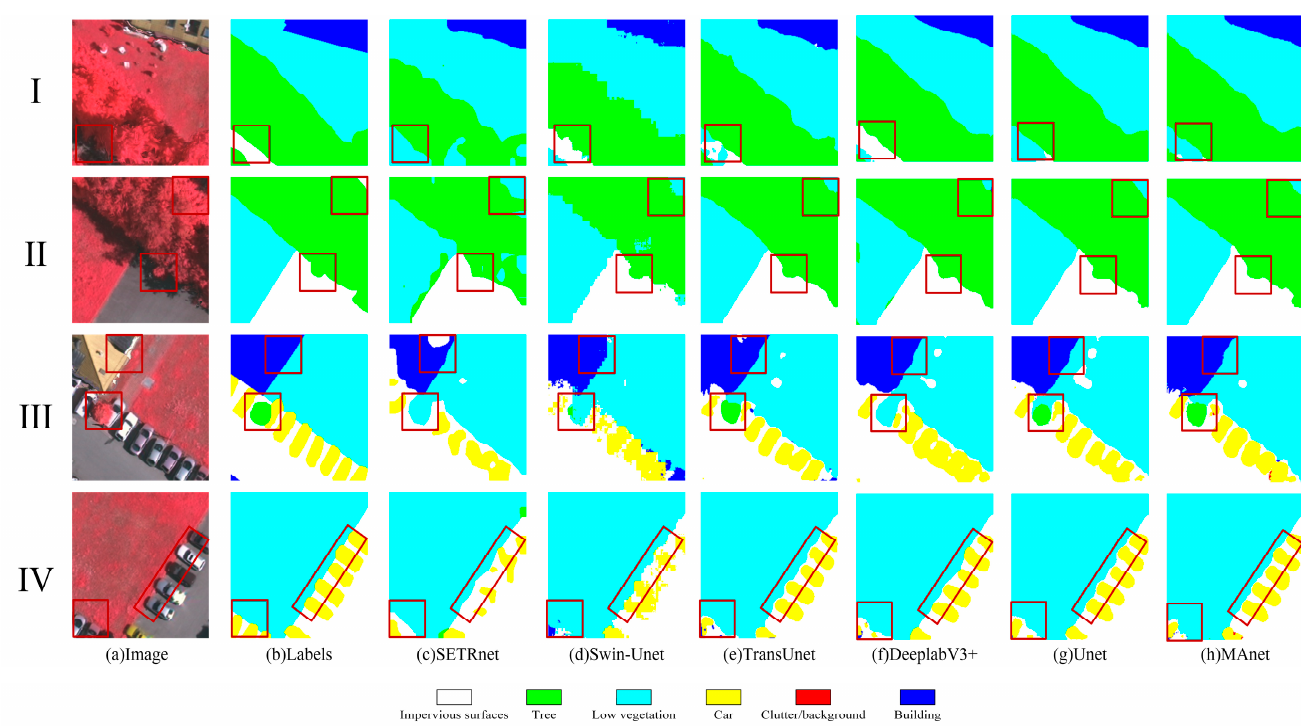
Figure 14. Classification results of CNN and transformers on the Vaihingen data set. The red boxes are where the differences between the five network segmentations are large.